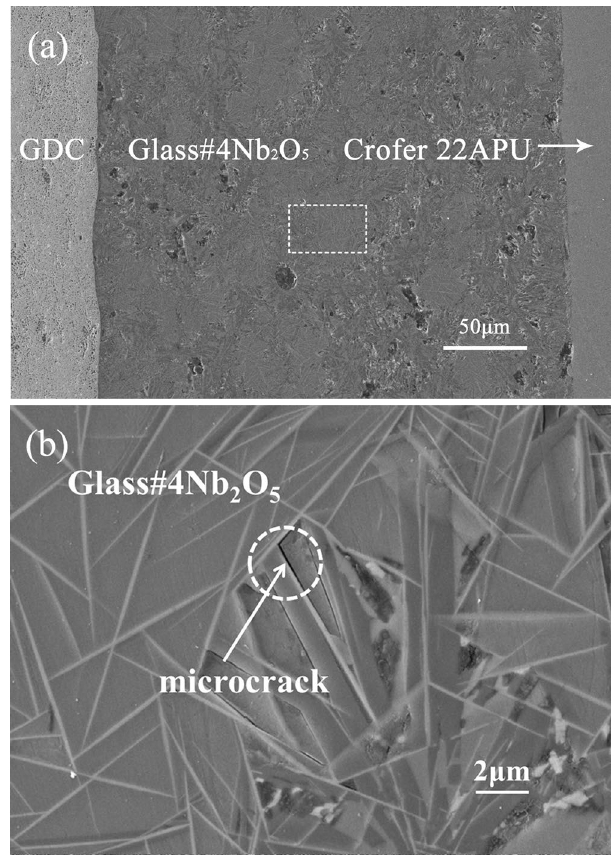
Figure 1. ( a ) Micrograph of the GDC/glass#4 Nb 2 O 5 /Crofer 22APU after 50 thermal cycles; ( b ) is a magnified image of the selected region in ( a